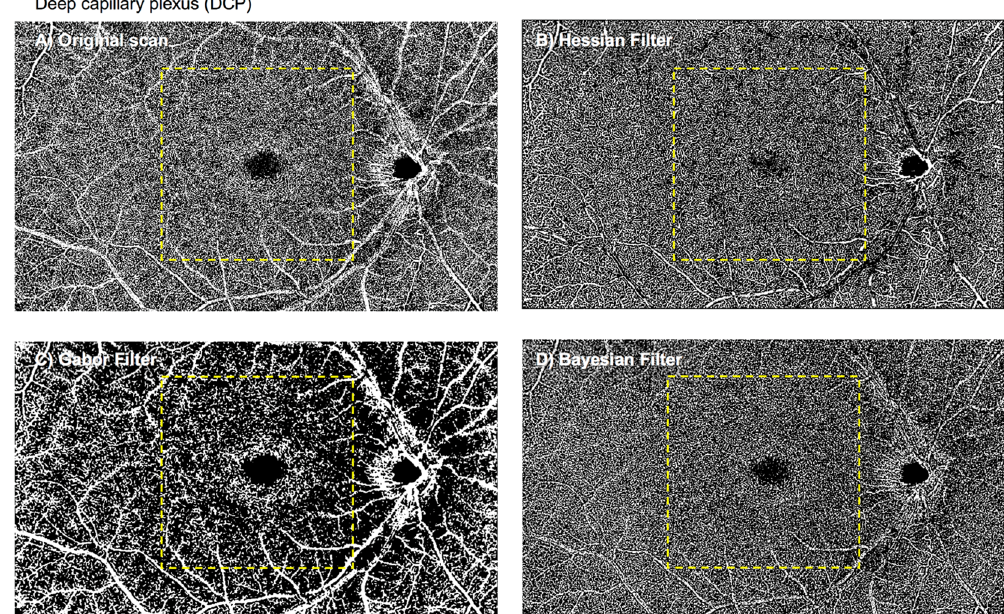
Figure 3. Deep capillary plexus: original scan ( A ) and enhanced with various filters ( B – D ). Perfusion densities were investigated in 2 different regions of the deep capillary plexus: (1) the macular region (within yellow dotted box) with a 6 × 6-mm 2 region centred over the fovea and (2) the peripheral region (outside the yellow dotted